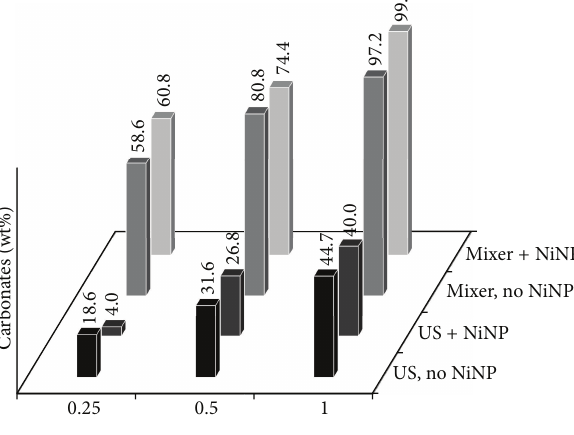
Figure 3: Carbonate content after CaO mineral carbonation, using S/L ratio of 50 g/1000 mL, determined by QXRD. Figure 4: Carbonate content after MgO mineral carbonation, using S/L ratio of 35.95 g/1000 mL, determined by